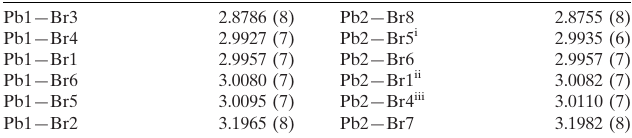
Selected geometric parameters (A˚ , (cid:3) ).